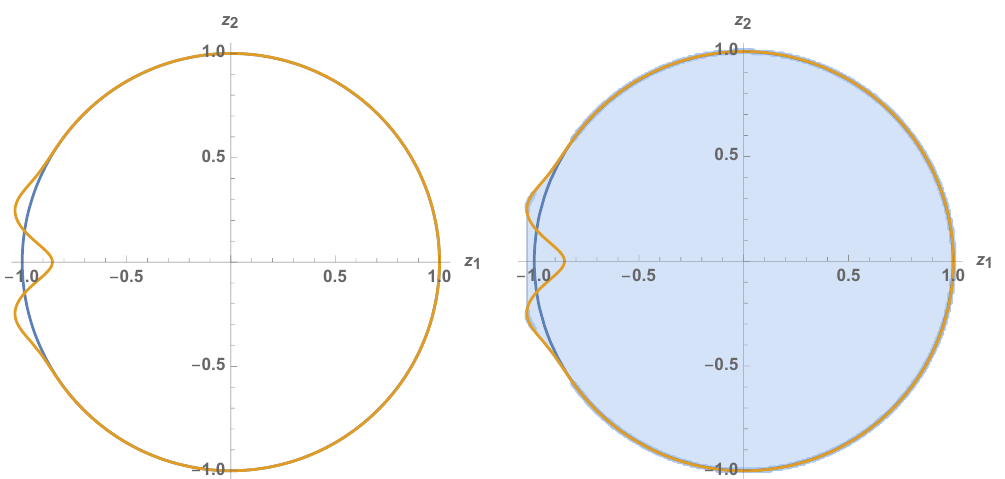
Figure 1 . Left: an extremality curve that naively violates the WGC as it does not enclose the unit circle. Right: the convex completion of the extremality curve does enclose the unit circle, hence the WGC is satis(cid:12)ed. For this to be possible the extremality surface must be somewhere locally non-convex, which is shown in appendix D to be impossible in the perturbative